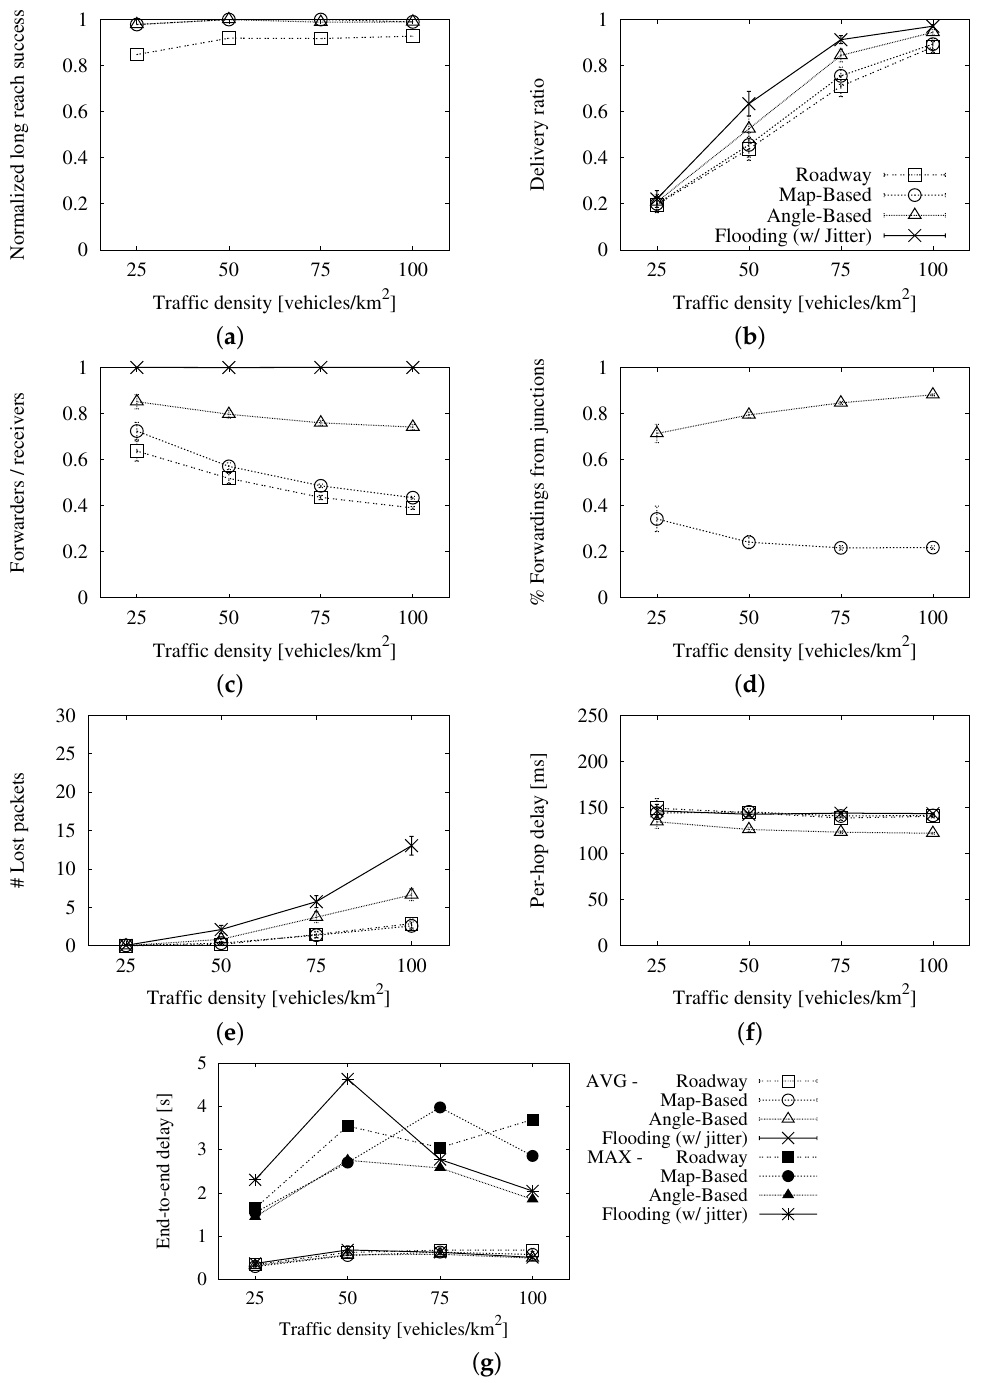
Figure 6. Comparison of the different schemes with the final values in the New York scenario: ( a ) long-reach success rate, normalized to the simple flooding’s rate. ( b ) delivery ratio; ( c ) forwarding ratio; ( d ) portion of relays from junctions; ( e ) number of lost packets; ( f ) average per-hop delay; ( g ) average and maximum end-to-end